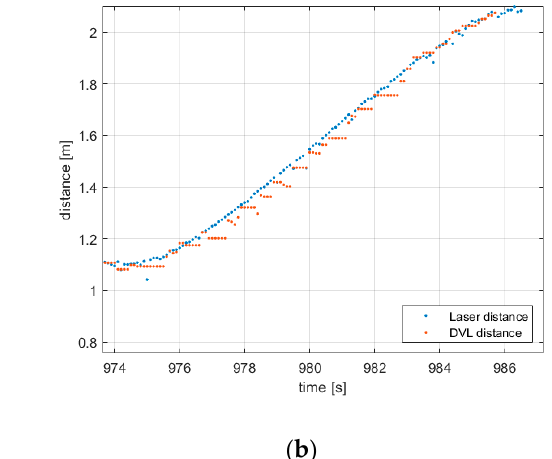
Figure 18. ( a ) shows a Kalman filter fusion of the distance measurements, with outliers removed. The outliers are indicated with circles. ( b ) Shows the Kalman prediction error which is the basis for estimating the noise levels for the two sensors.